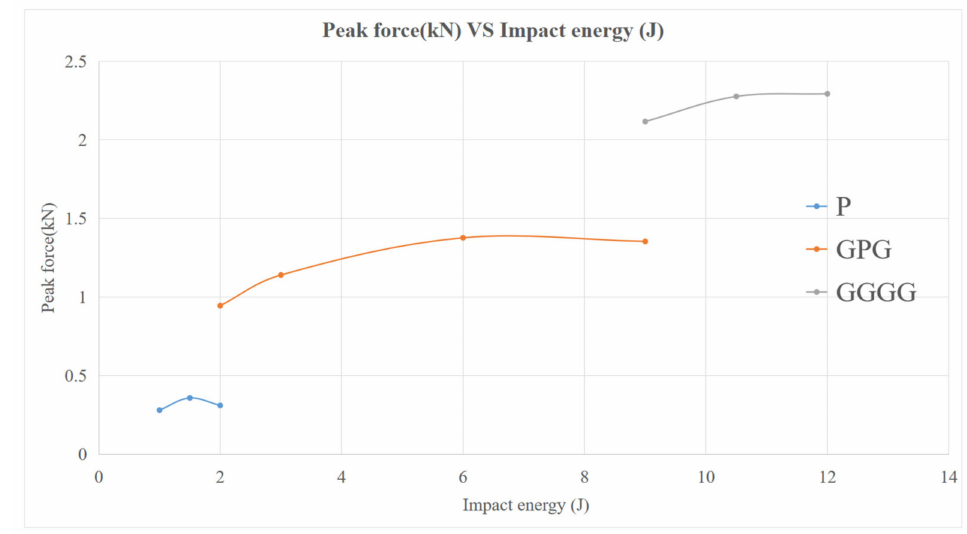
Figure 11. Peak force of